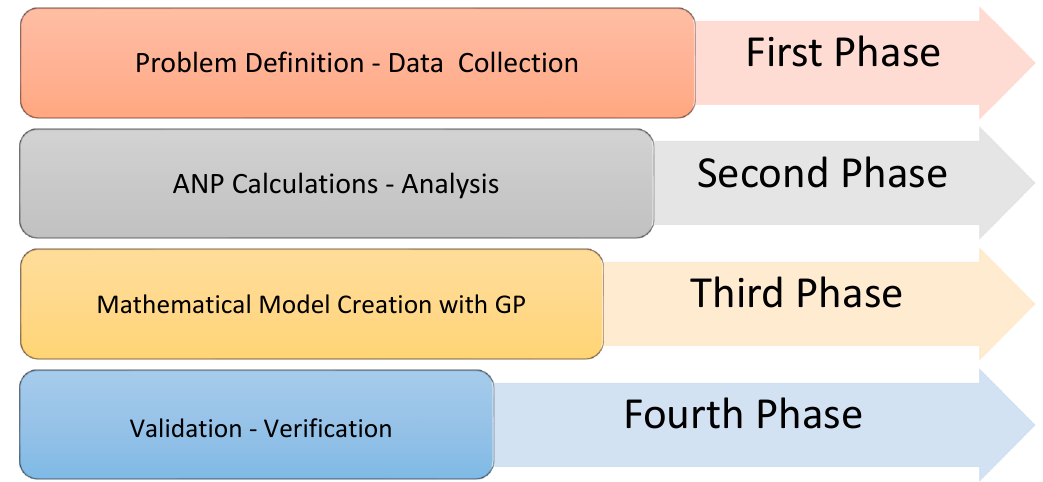
Figure 1. Schematic representation of the study.